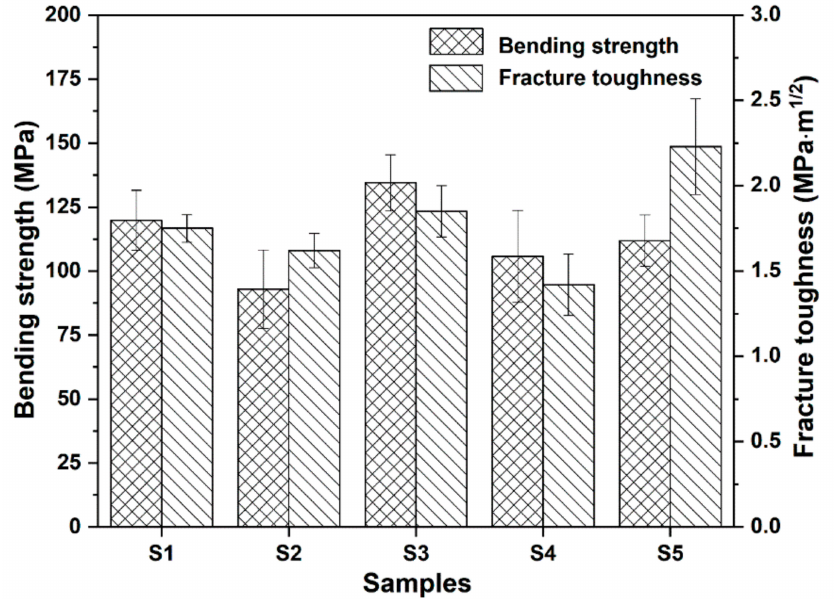
Figure 3. Mechanical properties of the samples.